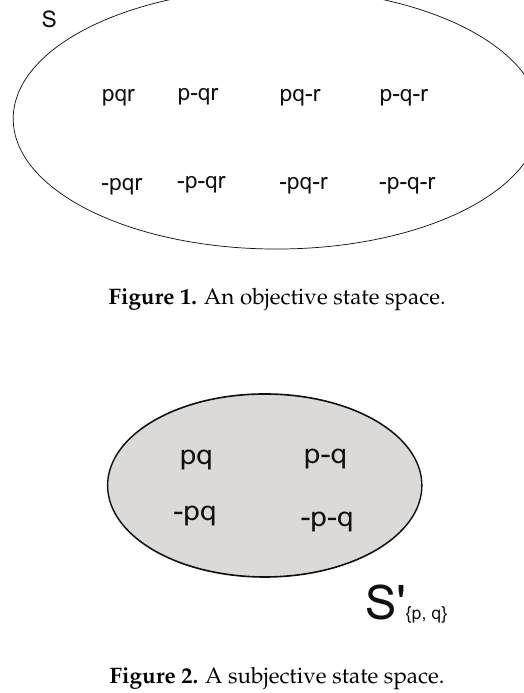
Figure 2. A subjective state space.